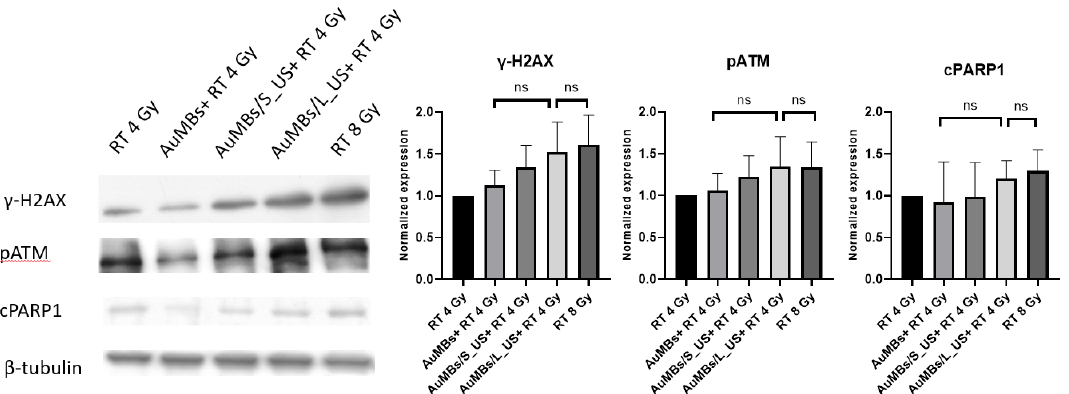
Figure 7. Representative Western blots and densitometric analyses of the levels of the DNA damage indicators (pATM and γ -H2AX) and the apoptosis marker cleaved PARP1 (cPARP1). n = 3 in each treatment arm.